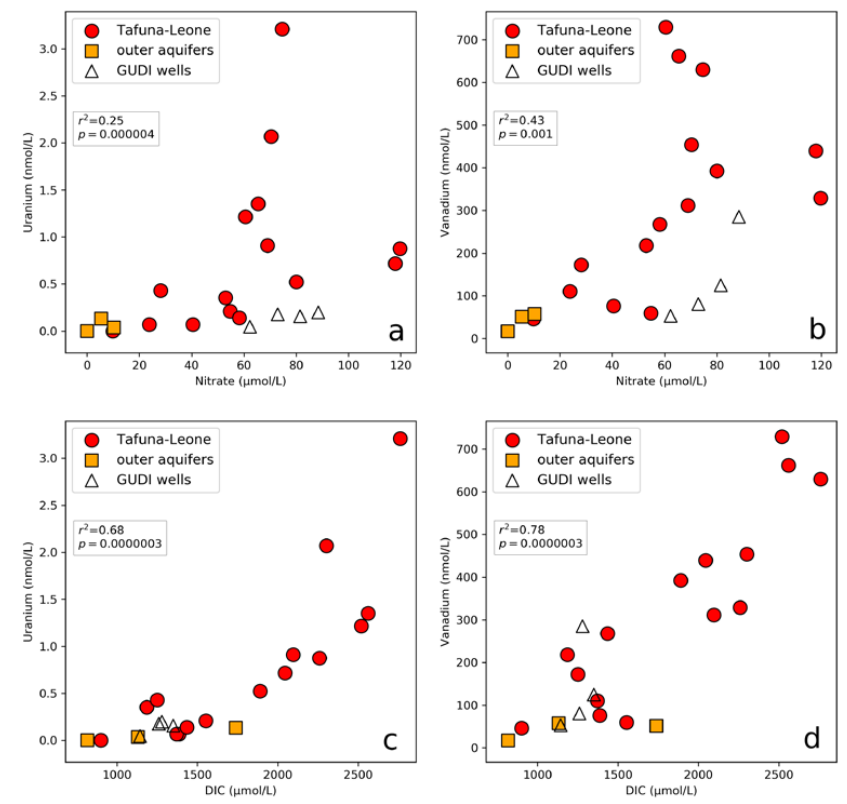
Figure 4. Scatterplots showing distribution and correlation between ( a ) NO 3 − and U, ( b ) NO 3 −